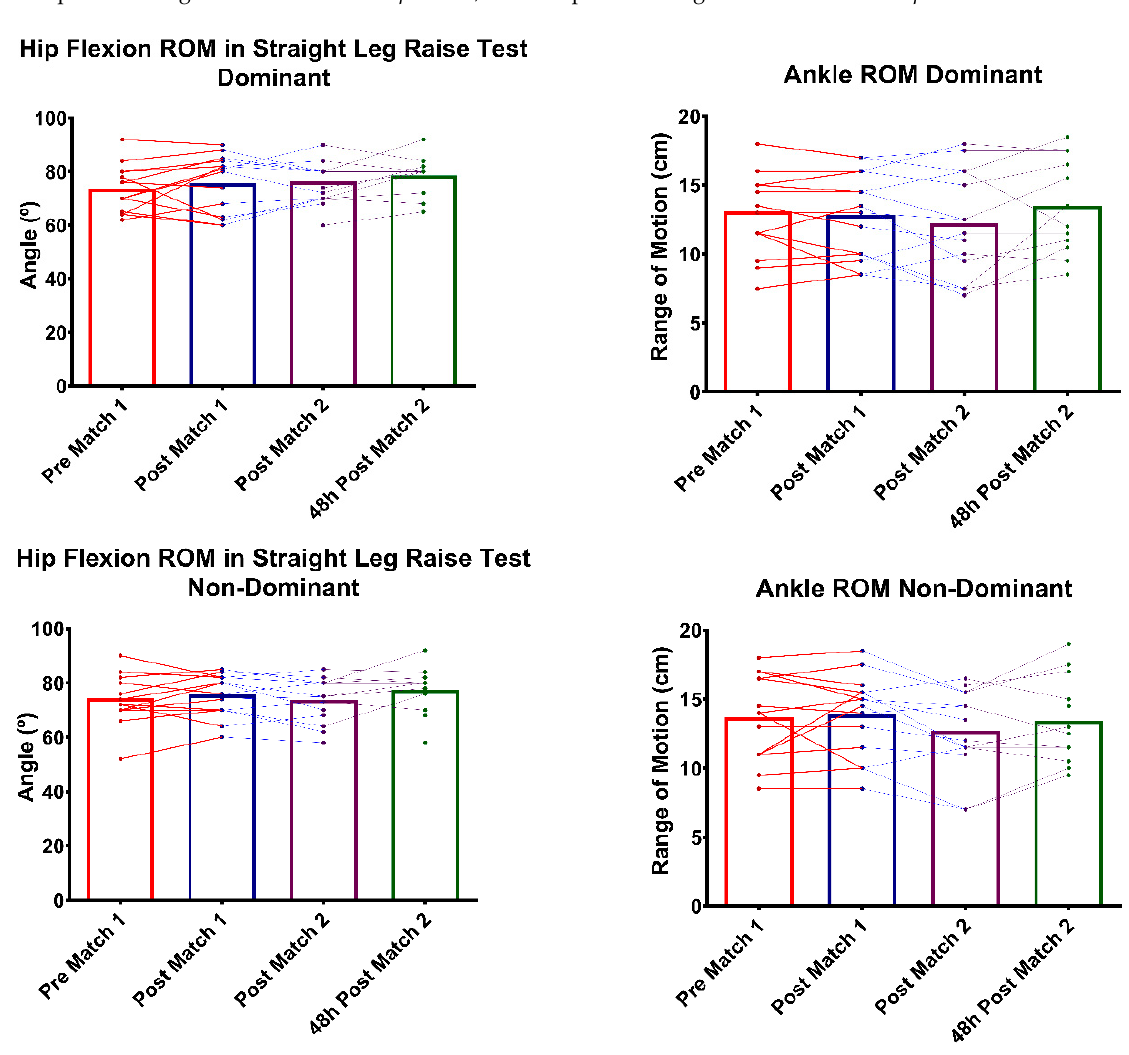
Figure 3. Mean and individual hip flexion and ankle dorsiflexion ROM in the dominant and non-dominant limbs.